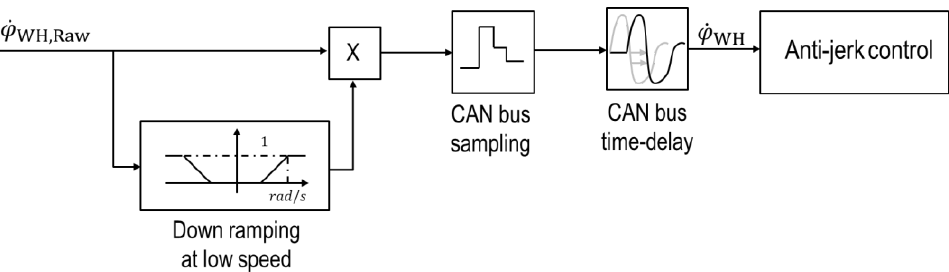
Figure 14. Emulation of a CAN bus network for the signals of the angular velocity of the vehicle wheel hub.